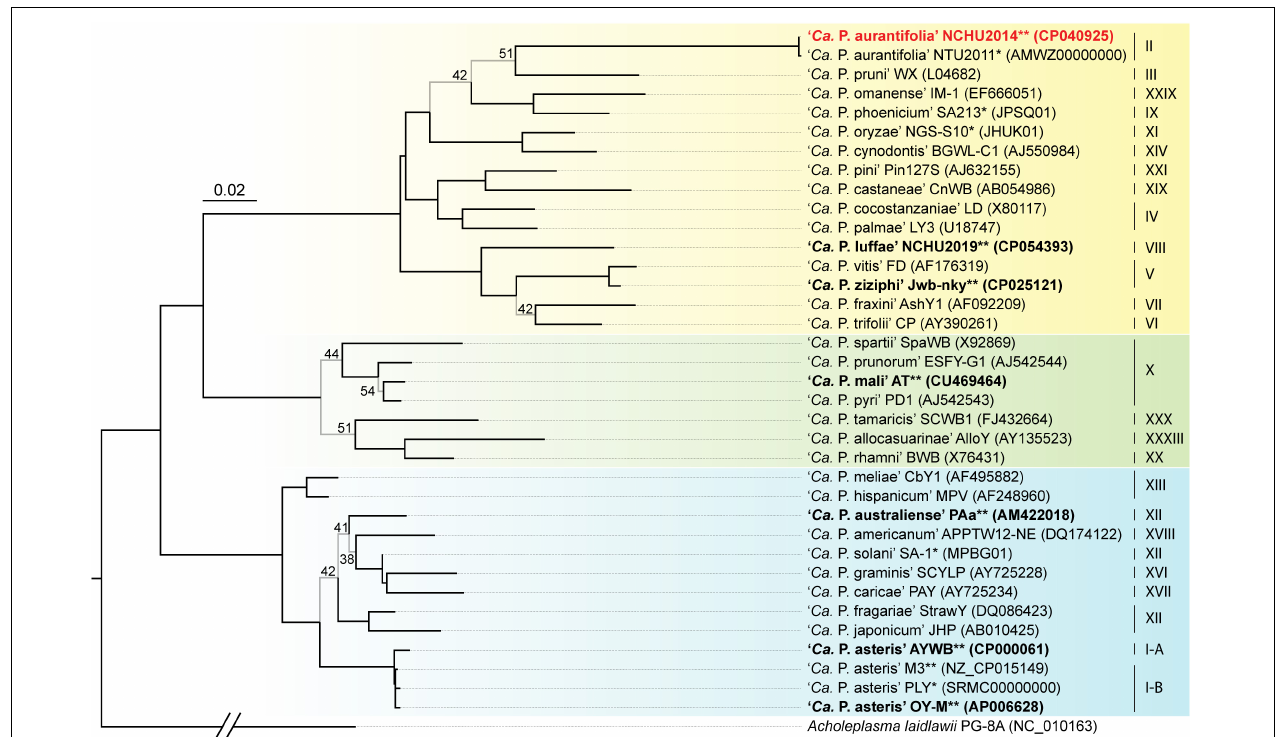
FIGURE 3 | Maximum likelihood phylogeny of representative phytoplasmas based on the 16S rRNA genes. The internal branches with < 60% bootstrap support are drawn in light gray, and the support values are labeled. Strains with genome sequences available are highlighted (“*”, draft; “**”, complete), those included in the genome comparisons are in bold. The focal strain of this study, ‘ Ca . P. aurantifolia’ NCHU2014, is highlighted in red. Sequence accession numbers are provided in parentheses following the strain names. For genome sequences with two 16S rRNA gene sequences available, the first one (i.e., the one with a smaller numerical value in locus tag) was selected. The 16Sr group assignments are provided on the right. Background colors are used to highlight the three phylogenetic clusters of phytoplasmas (I: blue; II; green; III: yellow). Acholeplasma laidlawii is included as the